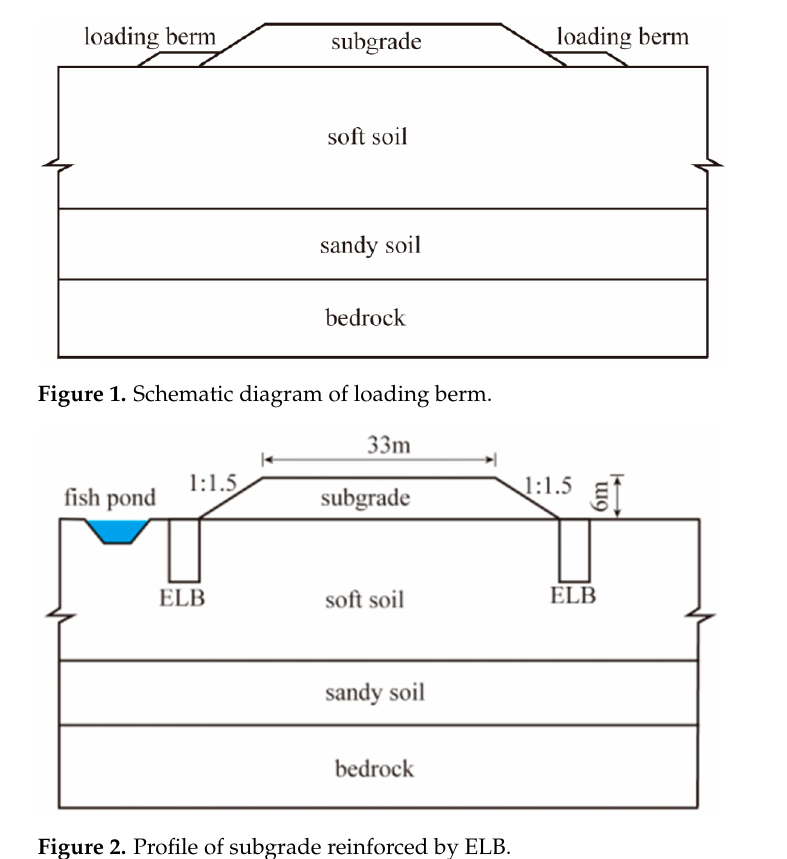
Figure 2. Profile of subgrade reinforced by ELB.